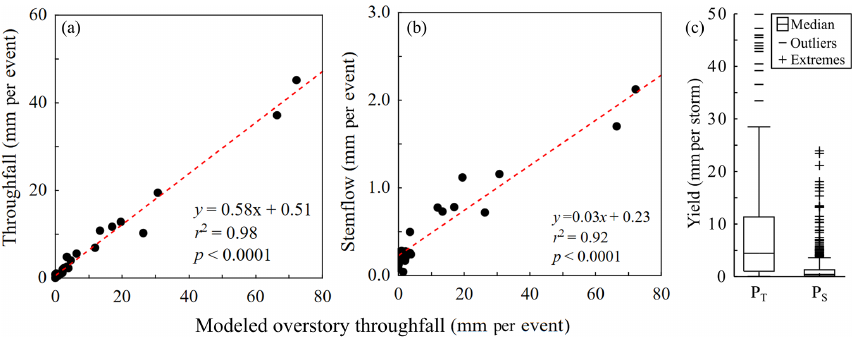
Figure 5. Scatter plots showing the response of Eupatorium capillifolium (dogfennel) (a) throughfall ( P T ) and (b) stemflow ( P S ) yields across all rainfall events (without occult precipitation). (c) Boxplot showing yields from individual P T gauges and plants’ P S . The line and box represent the median and interquartile range, respectively, and the whiskers represent the non-outlier range; other symbols represent outliers and extreme values.